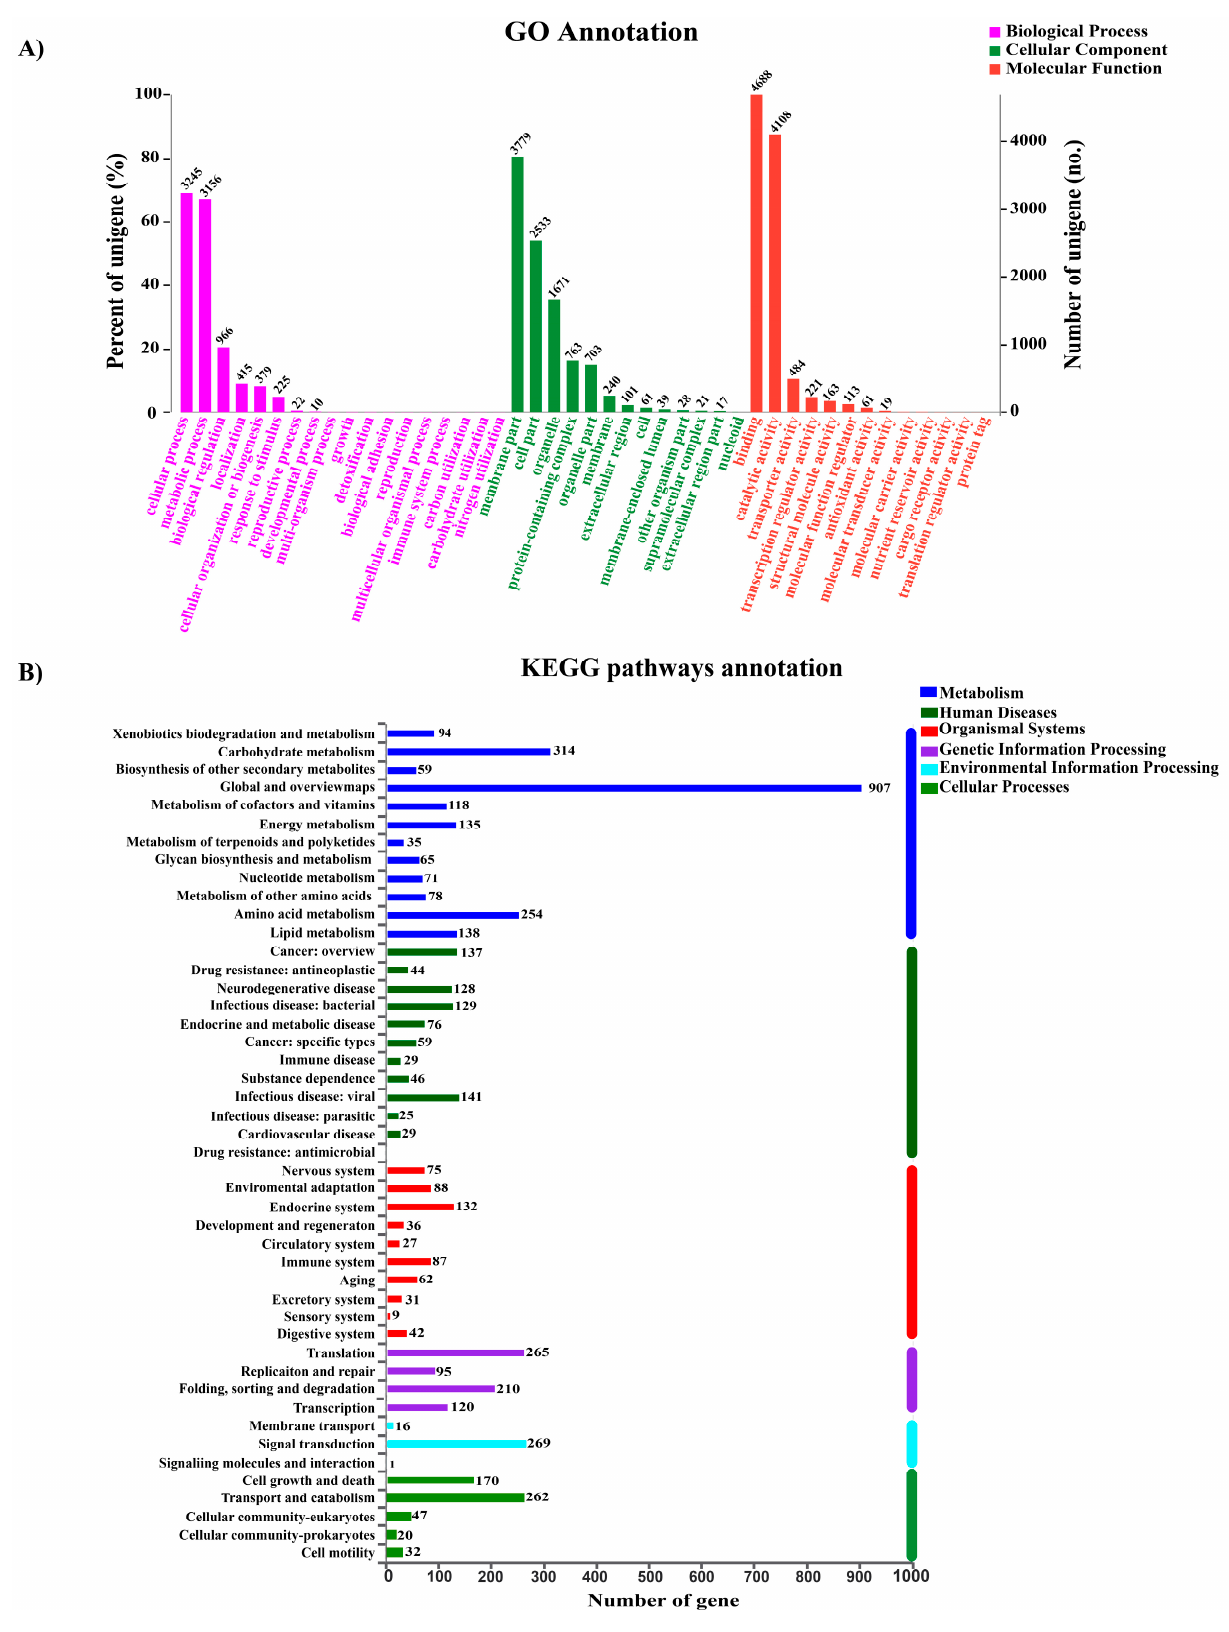
Figure 3. Gene function annotation of D . tabescens CPCC 401429 genome. ( A ) GO enrichment analysis of annotated genes from the strain CPCC 401429. ( B ) KEGG pathway annotation of the